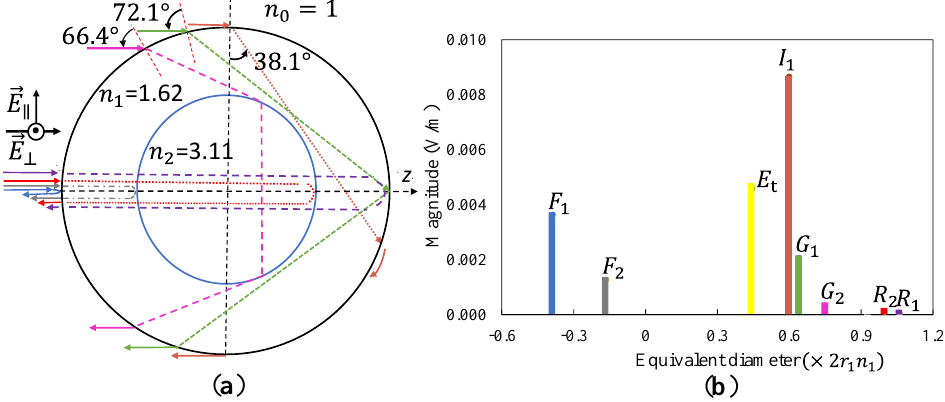
Figure 6. Backscattered wave for LCS 2: ( a ) Propagation of the backscattered wave components; ( b ) Magnitude and phase center of the backscattered wave components.